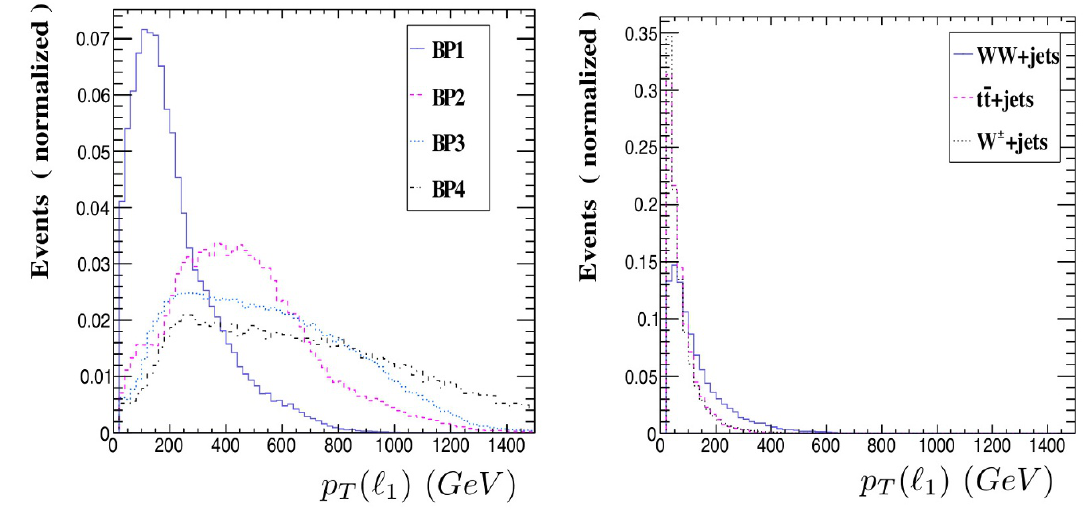
Figure 5 . Same as in (cid:12)gure 3 but for the transverse momentum of the leading lepton. BP1 BP2 BP3 BP4 diboson top-antitop